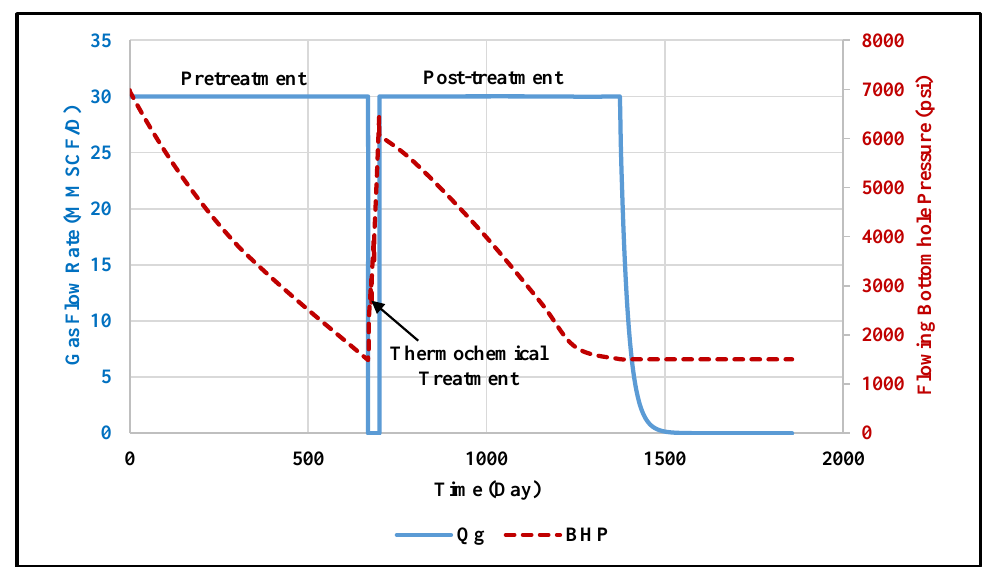
Figure 18. Profiles of gas-production rate and flowing bottom-hole pressure prior to and after thermochemical treatment.